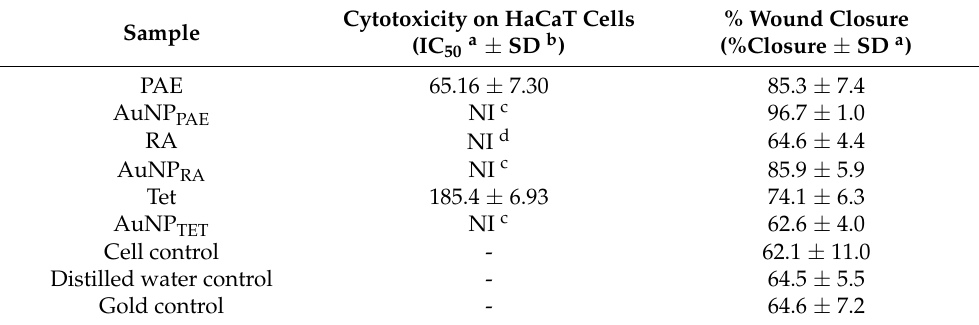
Table 2. Cytotoxicity and percentage wound closure of Plectranthus aliciae ethanolic extract (PAE), P. aliciae gold nanoparticles (AuNP PAE ), rosmarinic acid (RA), rosmarinic acid gold nanoparticles (AuNP RA ), tetracycline, and tetracycline gold nanoparticles (AuNP TET ) compared to the cell growth, distilled water, and gold salt controls.